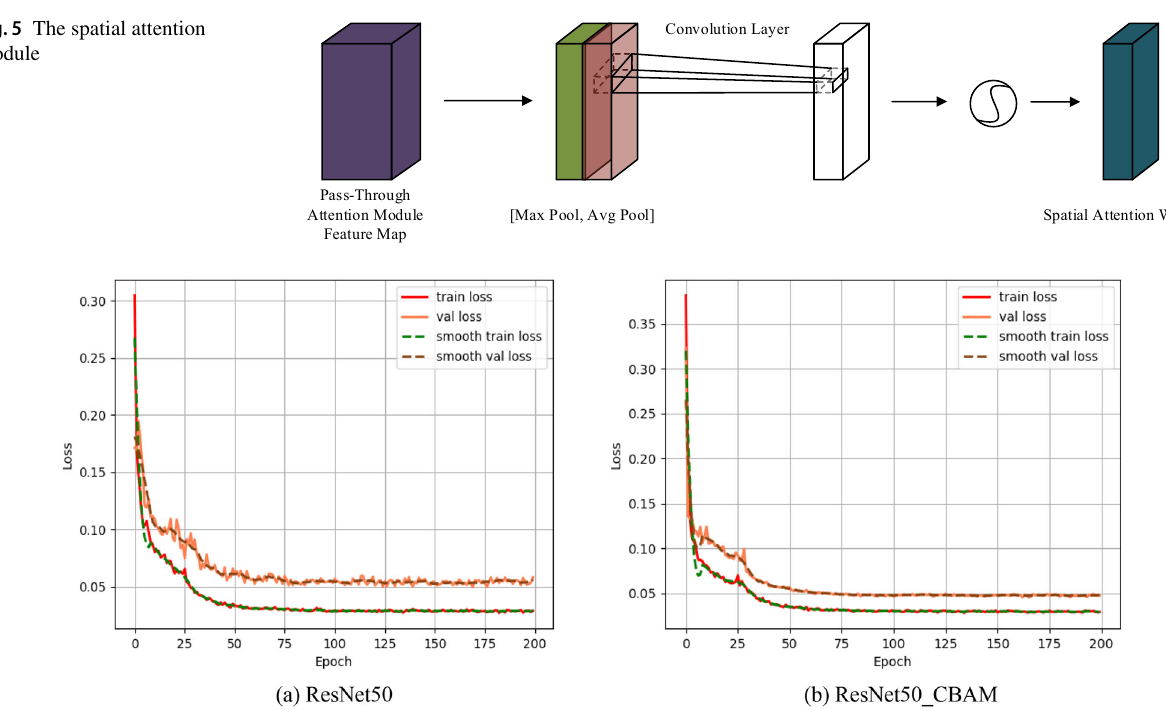
Fig. 6 Comparison of training loss function with CBAM attention mechanism